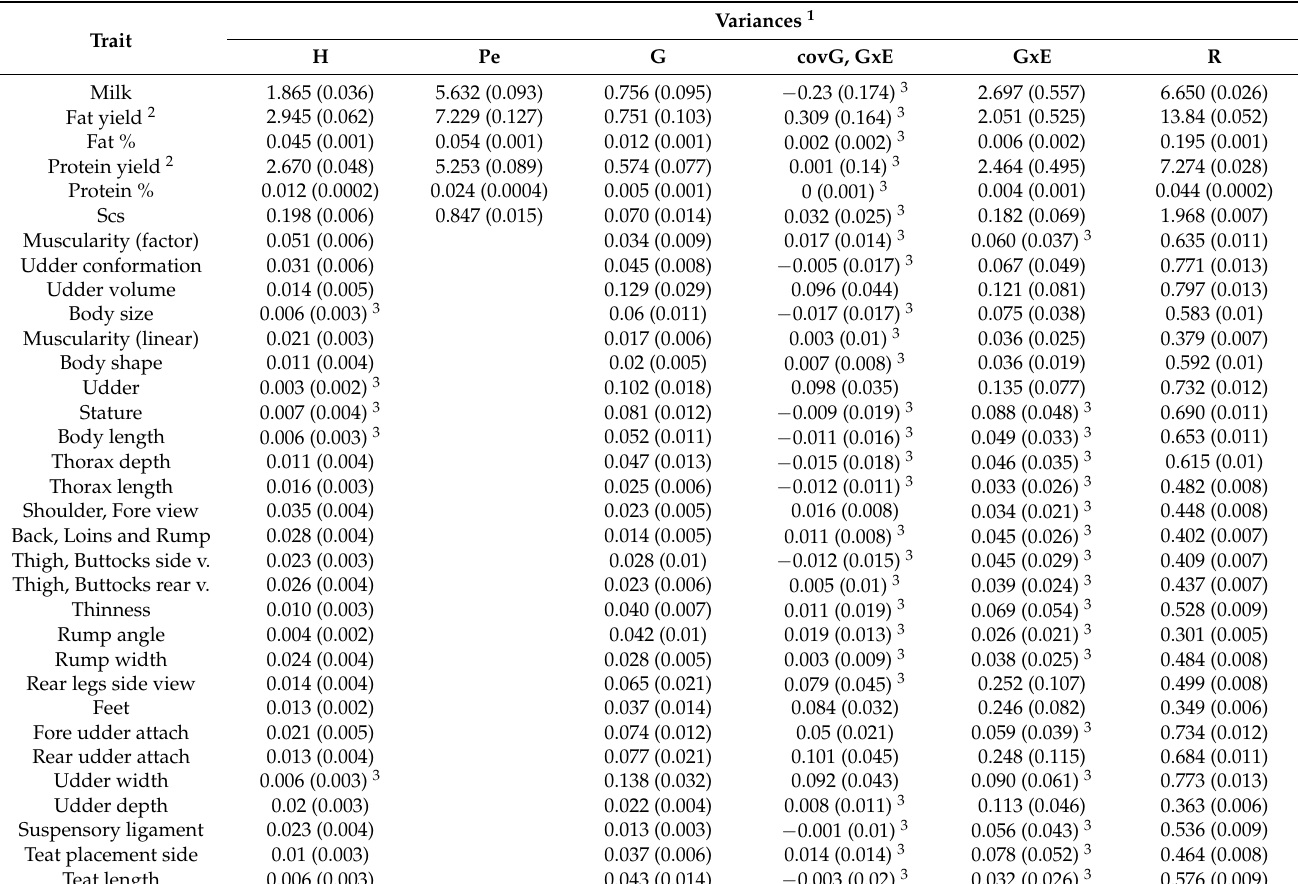
Table 2. Variance components (posterior means and SE in brackets) estimated from sire model including